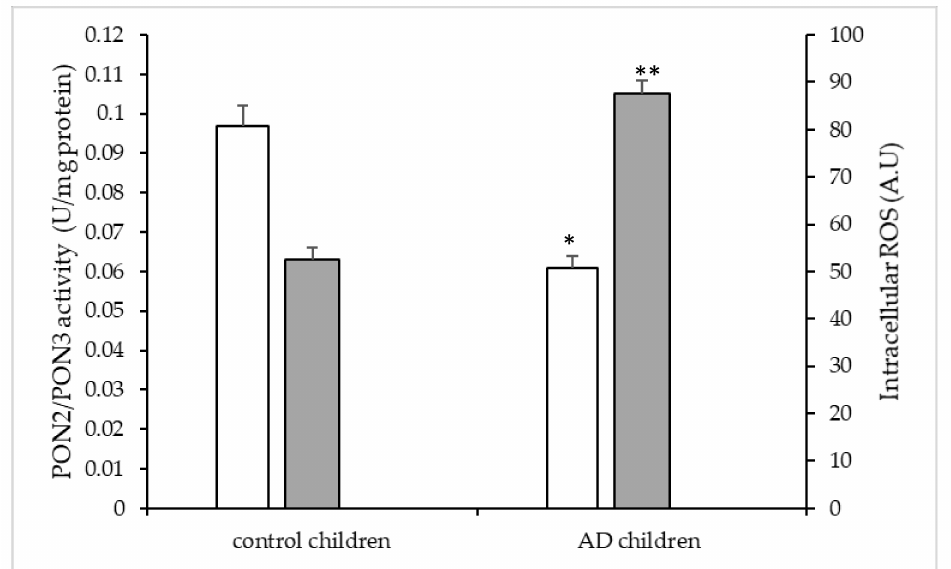
Figure 1. PON2/3 lactonase activity (white bar) and intracellular ROS (grey bar) in peripheral blood mononuclear cells (PBMNCs) isolated from AD and control children. Results reported as mean ± SE. * p < 0.001 vs. PON2/3 activity in cells of control children; ** p < 0.001 vs. ROS levels in cells of control